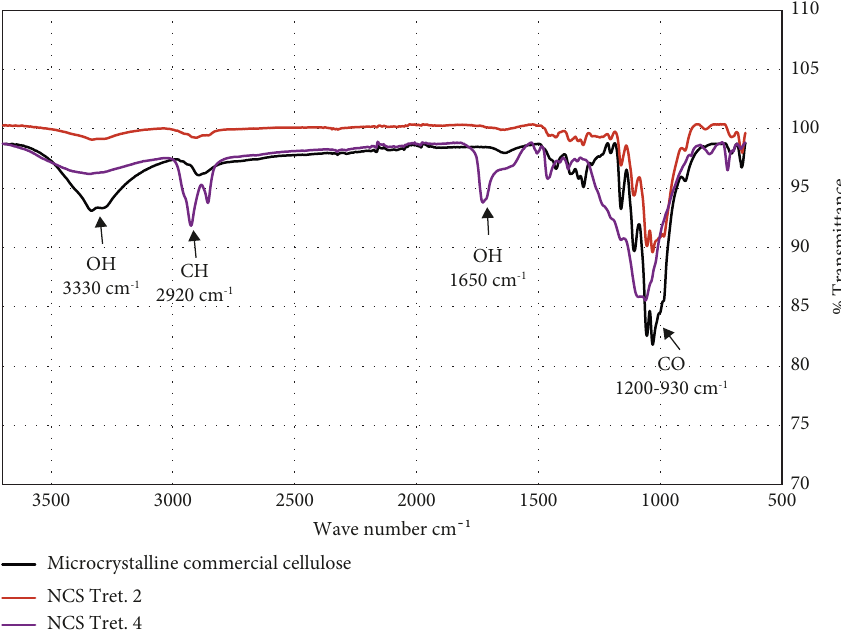
Figure 5: Nanocellulose comparison obtained by acid hydrolysis from rice husk characterized by Fourier transform infrared spectroscopy (FTIR). (Nanocellulose tre. 2. and tret. 4). (source: author Figure 6, the energy consumption properties of NC and its precursors during pyrolysis, measured a DSC analysis be- tween ranges of 50 to 350 ° C, refect the melting point of two nanocellulose (NC) samples treated after enzymatic hydrolysis.